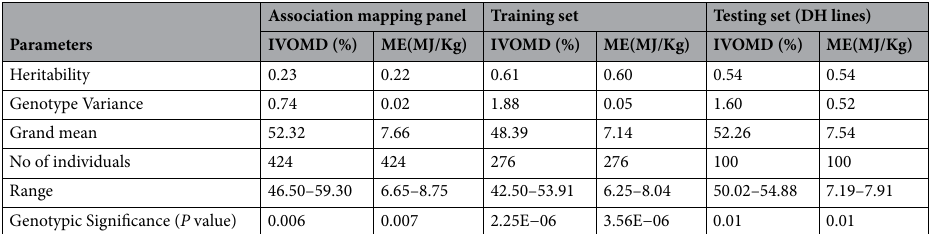
Association mapping panel Training